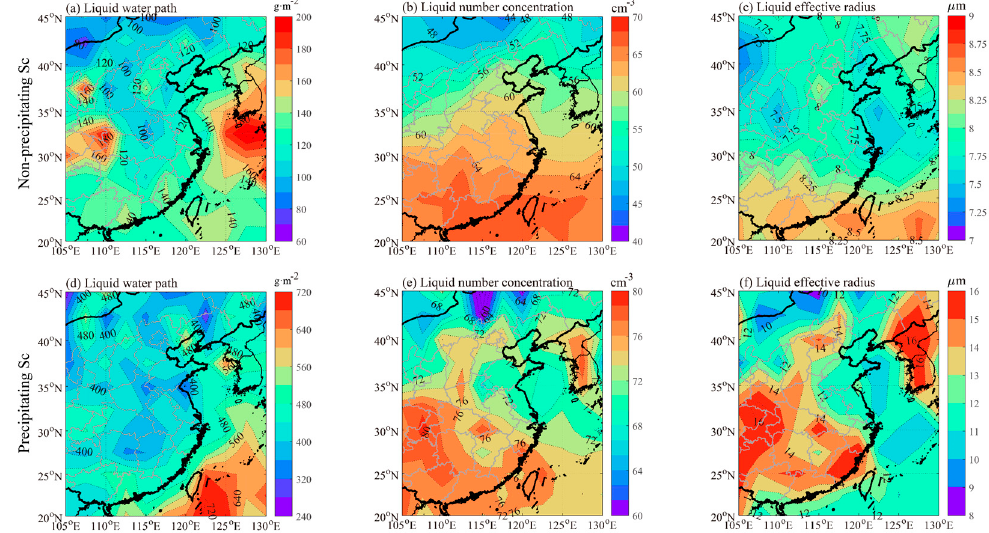
Figure 5. Spatial distributions of the average microphysical characteristics of Sc clouds, including the liquid water path ( a , d ), liquid number concentration ( b , e ) and liquid effective radius ( c , f ) of NPS ( a – c ) and PS ( d – f ) clouds over EC.